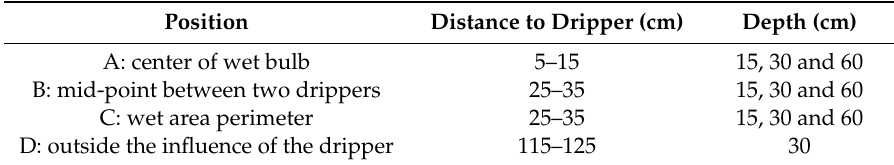
Table 2. Deployment of 10HS sensors in the study plot.